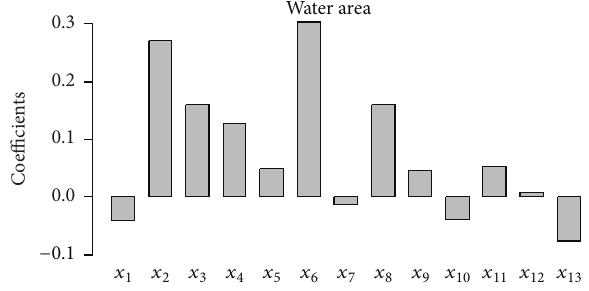
Figure 9: The coefficients of built-up land. Figure 10: The coefficients of water